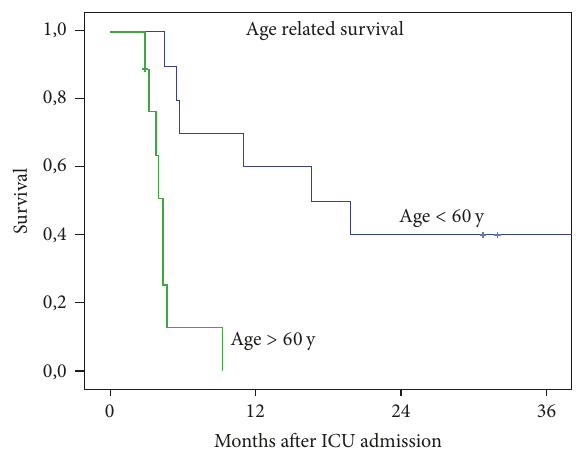
Figure 2: Survival of the patients related to the age at the time point of ICU admission.